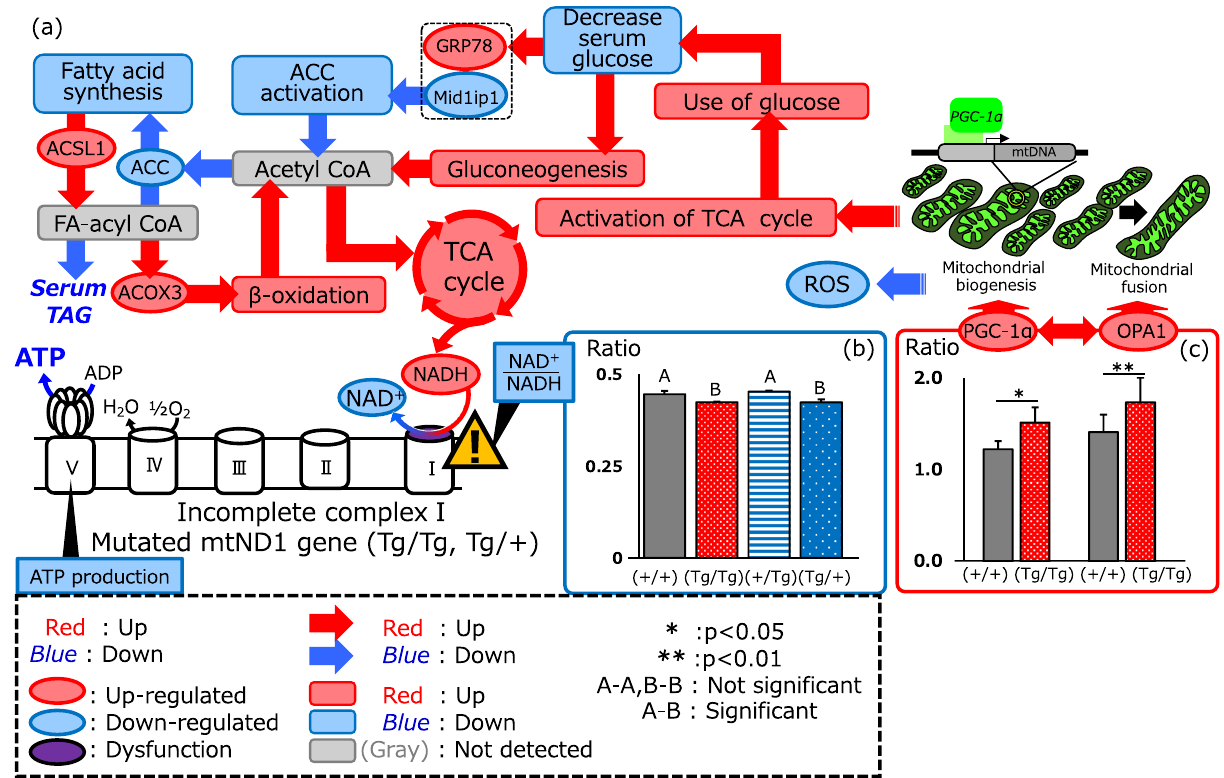
Figure 3. Physiological conditions of GH homozygous fish. ( a ) Summary of physiological conditions in the (Tg/Tg) and (Tg/+) fish. Differential expression of the glucose starvation gene ( GRP78 ), MID1 interacting protein 1 ( MID1IP1 ), A long-chain-fatty-acid-CoA ligase 1 ( ACSL1 ), acetyl-CoA carboxylase ( ACC ), and acyl- CoA oxidase 3 ( ACOX3 ) in (Tg/Tg) fish was obtained from Sugiyama et al. 18 . ( b ) The NAD + /NADH ratio was measured using LC–MS ( n = 3: different fish), which was significantly decreased [ p < 0.05; ANOVA followed by PLS. A–B indicate significant differences in (Tg/Tg) and (Tg/+) fish vs. control and (+/Tg) fish]. ( c ) Peroxisome proliferator-activated receptor γ coactivator-1 ( PGC-1α ) and mitochondrial dynamin-like GTPase ( OPA1 ) levels were quantified by western blotting (See “Supplementary Information” and “Supplementary figures”). The intensities of the four PGC-1α and OPA1 signals were divided by the β-actin signal; the vertical bars represent standard errors. Statistical significance was obtained by Student’s t -test. * p < 0.05; ** p <